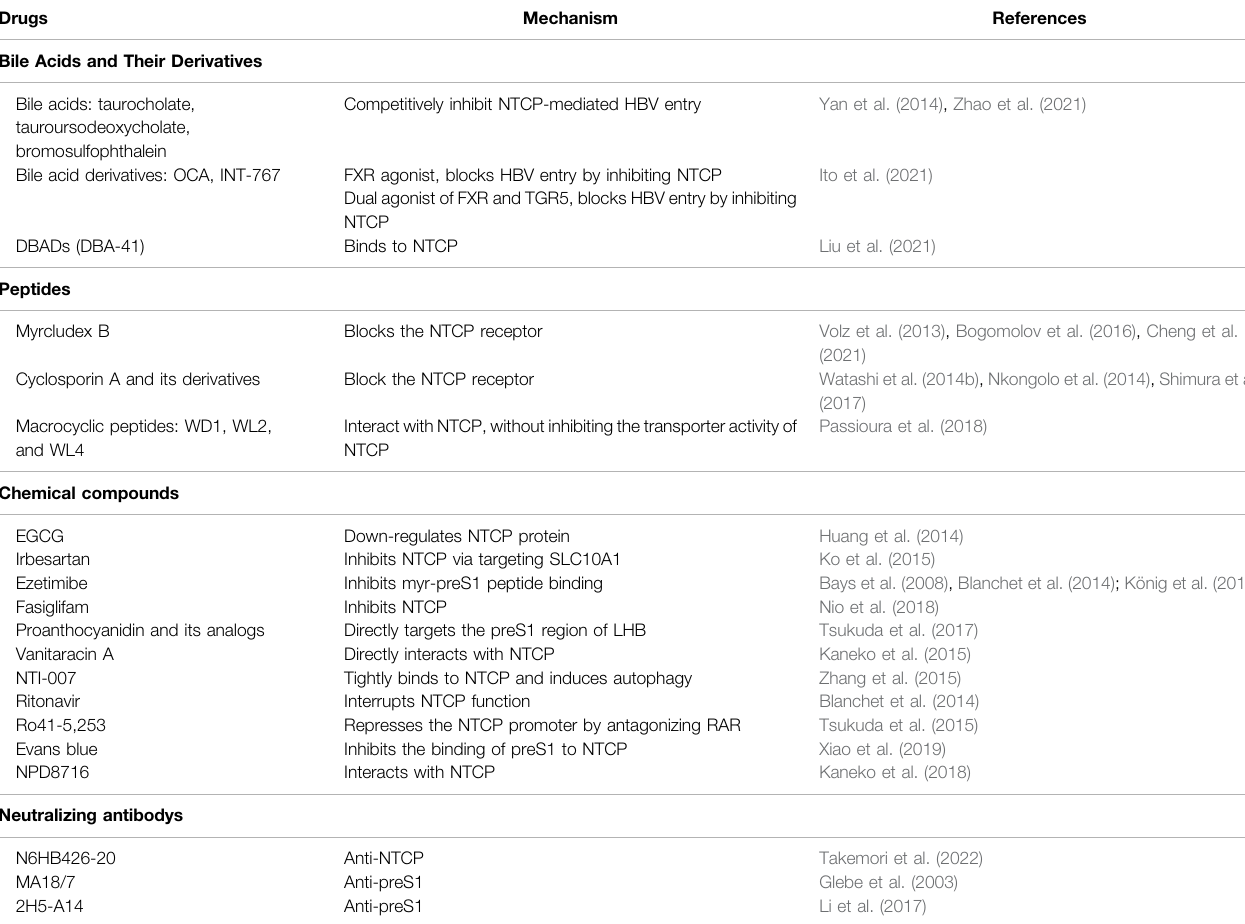
TABLE 1 | Examples of HBV entry inhibitors targeting NTCP-mediated viral